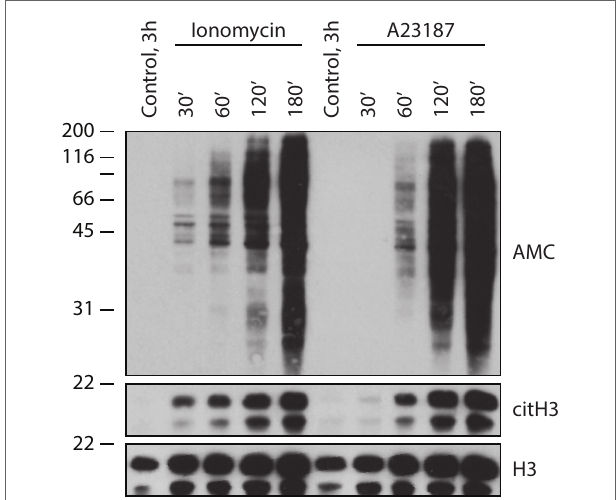
FigUre 1 | Calcium ionophores induce cellular hypercitrullination in neutrophils . After informed consent, peripheral blood neutrophils were isolated from healthy donors as previously described (58), resuspended in HBSS/10 mM Hepes/1.5 mM CaCl 2 , and incubated with 1 μ M ionomycin or 5 μ M A23187 at 37°C for 30–180 min. Neutrophils incubated for 3 h in the absence of stimulus were used as negative control. General protein citrullination was visualized by anti-modified citrulline (AMC) immunoblotting (59) (upper panel) and histone H3 citrullination (Cit-H3) using antibodies against citrullinated histone H3 (citrulline 2 + 8 + 17) (Abcam, Cat# ab5103) (middle panel). Histone H3 (H3) was detected as loading control (lower panel) (anti-histone H3, Abcam, Cat# ab1791). The experiments were performed on at least three separate occasions with similar